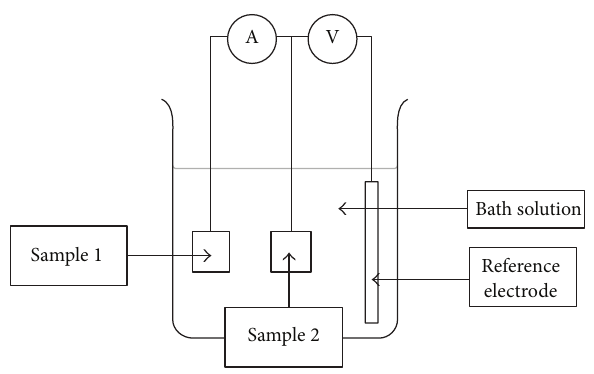
Figure 1: Setup for electrochemical noise measurements.